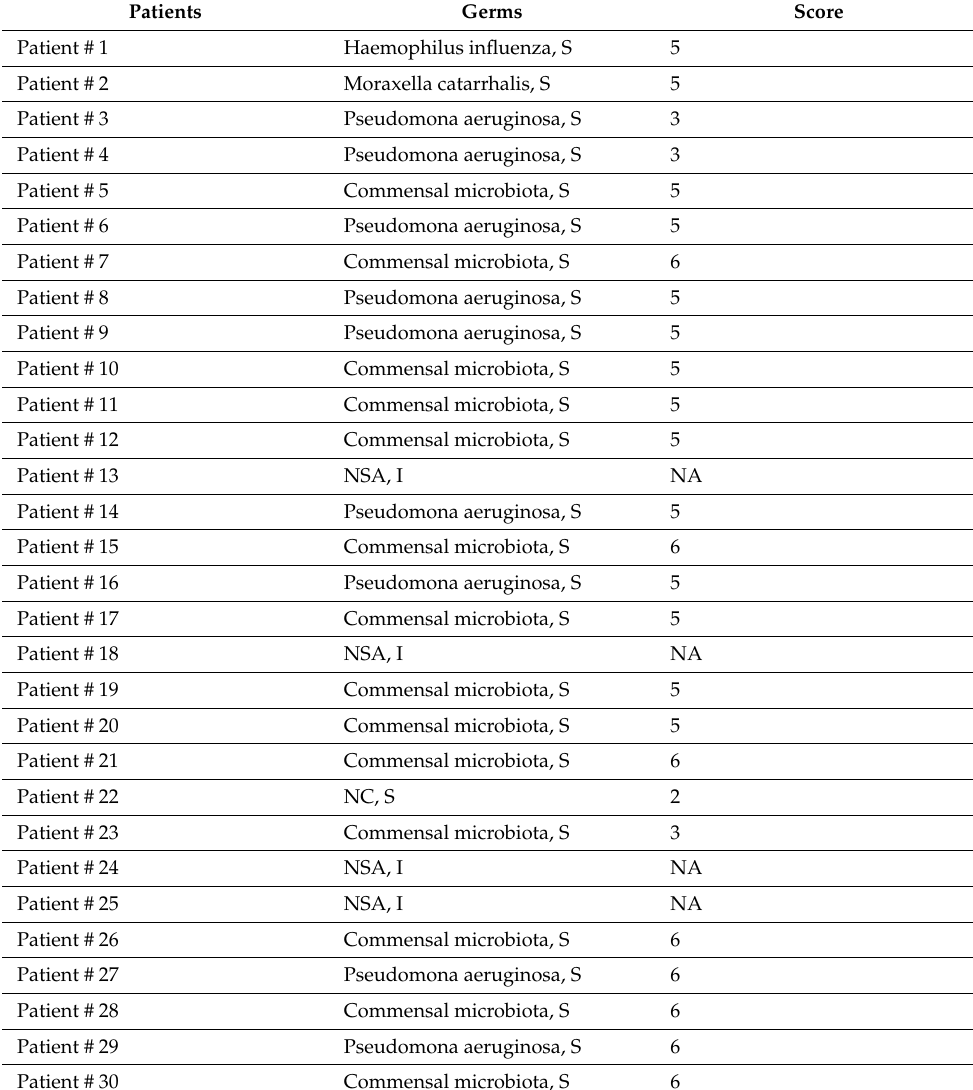
Table 4. Microbiological status of the study